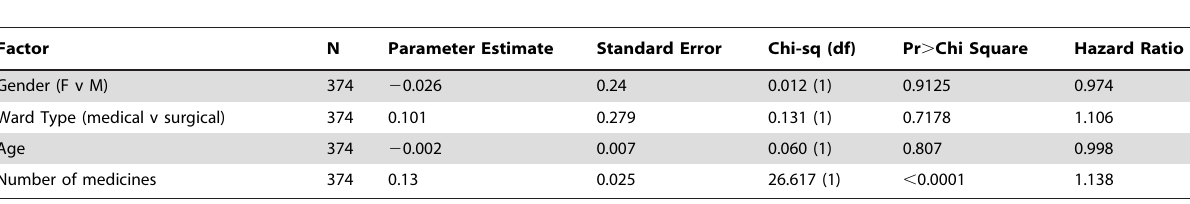
Table 6. Risk factors for adverse drug reaction assessed by multivariate analysis.